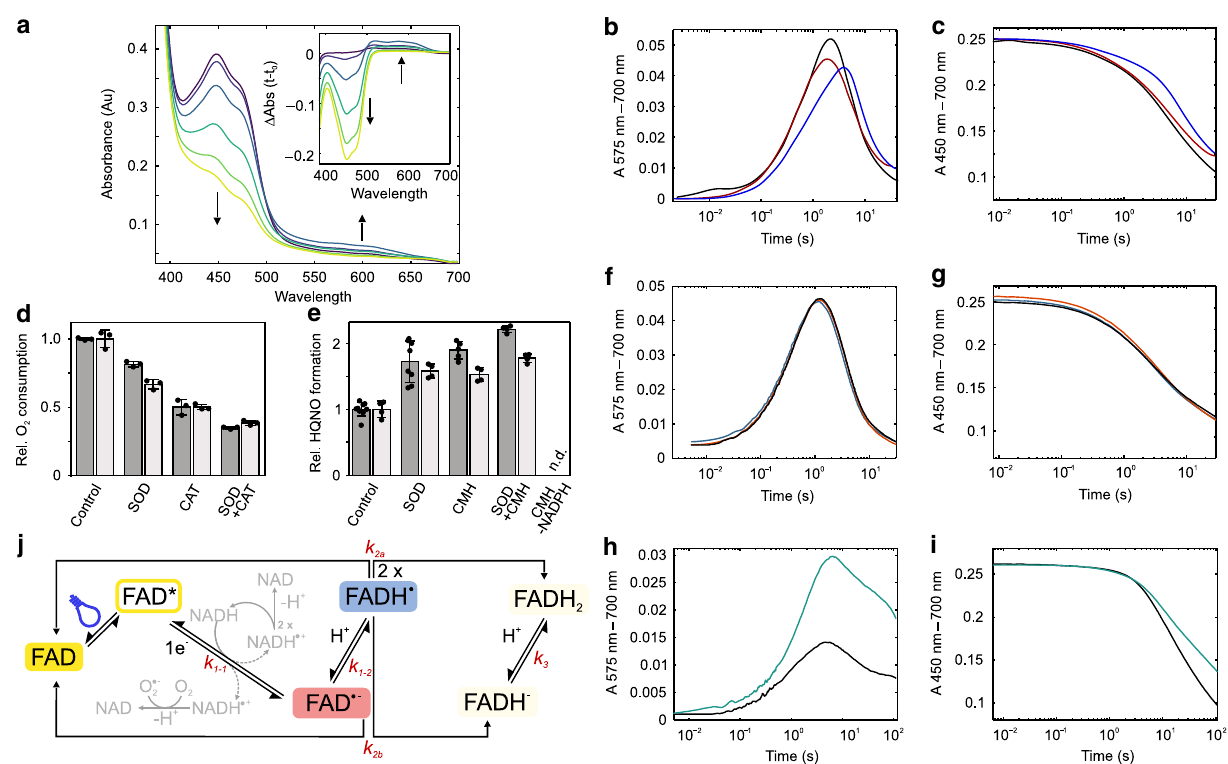
Fig. 5 Flavin semiquinone formation in PqsL photoreduction. a UV/Vis spectra and difference spectra (inset) at different time points (purple 0 s, violet 0.4 s, blue 0.8 s, dark green 2.4 s, light green 7.2 s, yellow 48 s) during photoreduction of PqsL-Q by continuous illumination under anoxic conditions in phosphate/borate buffer, pH 8.3 and 1 mM NADPH. b , c Rapid kinetics of PqsL-Q photoreduction with NADPH (black), NADPH + CMH (red), or NADH (blue) monitored at 575 nm ( b ) and 450 nm ( c ). Traces re fl ect averages of at least 10 replicates, data were corrected for baseline drift and scaled to the exact fl avin content in the experiment. d In fl uence of O 2 (cid:129) − scavenging superoxide dismutase (SOD), and/or H 2 O 2 decomposing catalase (CAT) on oxygen consumption of PqsL (dark gray — PqsL, light gray — PqsL-Q, photoreduction with NADPH in a multiple turnover experiment). e , Effect of SOD and/or the radical reducing CMH on HQNO formation in the coupled PqsL/PqsBC assay under constant illumination. Dark gray - PqsL, light gray - PqsL-Q. Error bars indicate SD of at least three independent measurements (panels d , e ). f , g Rapid kinetics of PqsL-Q photoreduction with NADH (black), (4- R )-(4- 2 H)- NADH (orange) and (4- S )-(4- 2 H)-NADH (blue) at 575 nm ( f ) and 450 nm ( g ). h , i D 2 O solvent kinetic isotope effect on the photoreduction of PqsL-Q with NADH in tris-HCl/tris-DCl buffer at pH 8.35 (black) or pD 8.35 (green) monitored at 575 nm ( h ) and 450 nm ( i ). j Possible reaction routes of light- excited, PqsL-bound FAD. Bidirectional arrows re fl ect reactions in which the reverse rate could have signi fi cance. Side reactions of NADH (or NADPH) leading to superoxide formation are shown in